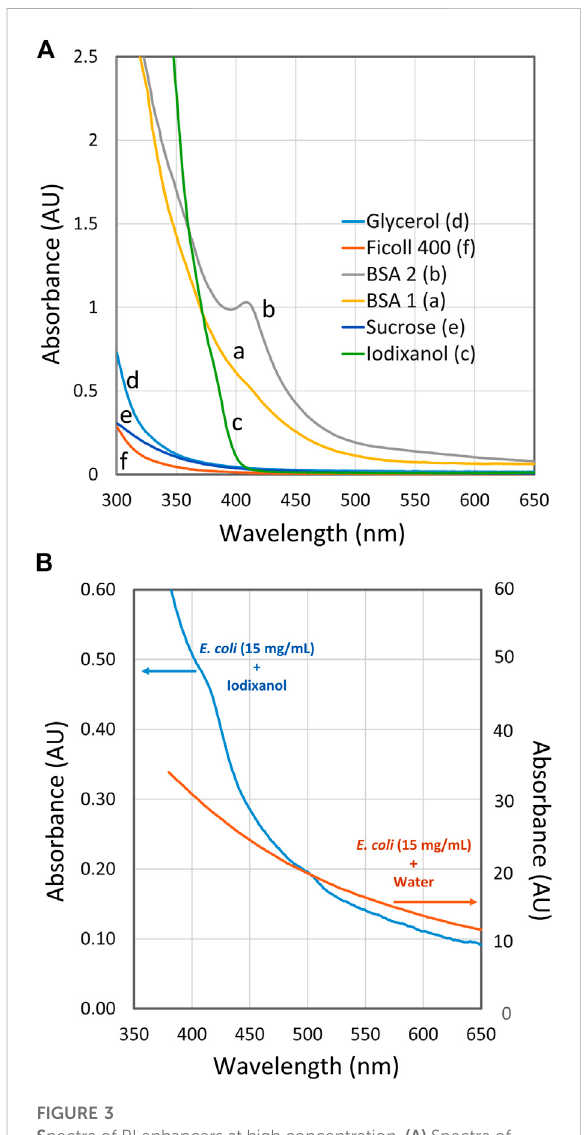
FIGURE 3 S pectra of RI enhancers at high concentration. (A) Spectra of refractive index (RI) enhancers: BSA 1 (a) , BSA 2 (b) , iodixanol (c) , glycerol (d) ,sucrose (e) andFicoll TM 400 (f) withwaterasreference. The concentration of the respective enhancers was close to the concentrations giving minimum scattering as shown in Figure 2, i.e., 300 mg/ml for BSA and Ficoll TM , 360 mg/ml for iodixanol, 550 mg/ml for sucrose and 900 mg/ml for glycerol. (B) Spectra of E. coli suspension (OD 600 = 13.5; about 15 mg/ml) in 36% (w/v) iodixanol and in